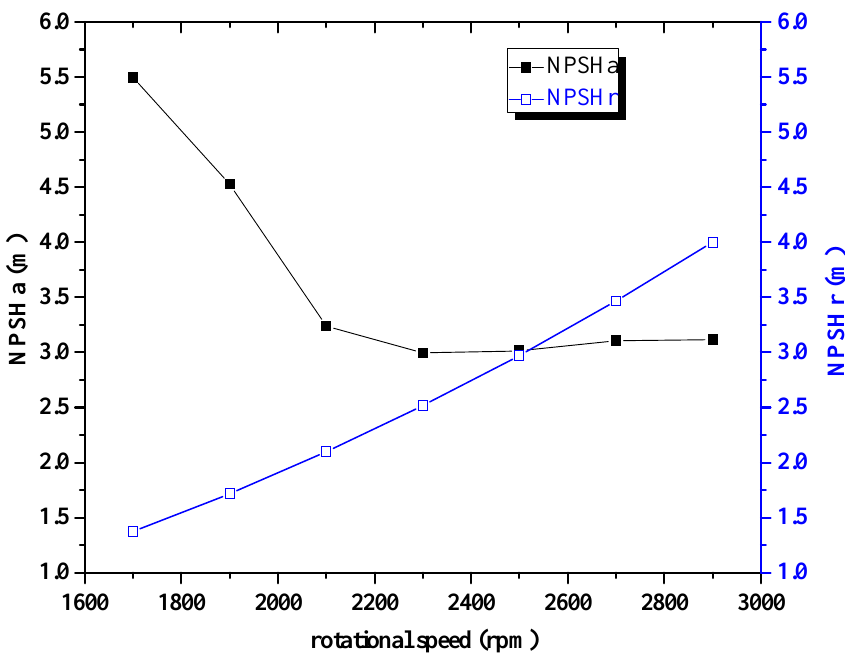
Figure 7. Changes in available net positive suction head (NPSHa) and required net positive suction head (NPSHr) under various rotational speeds.